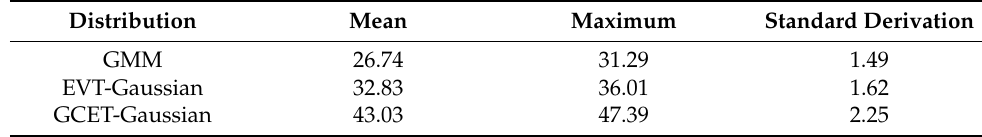
Table 7. Statistics of observed VPLs (in meters).